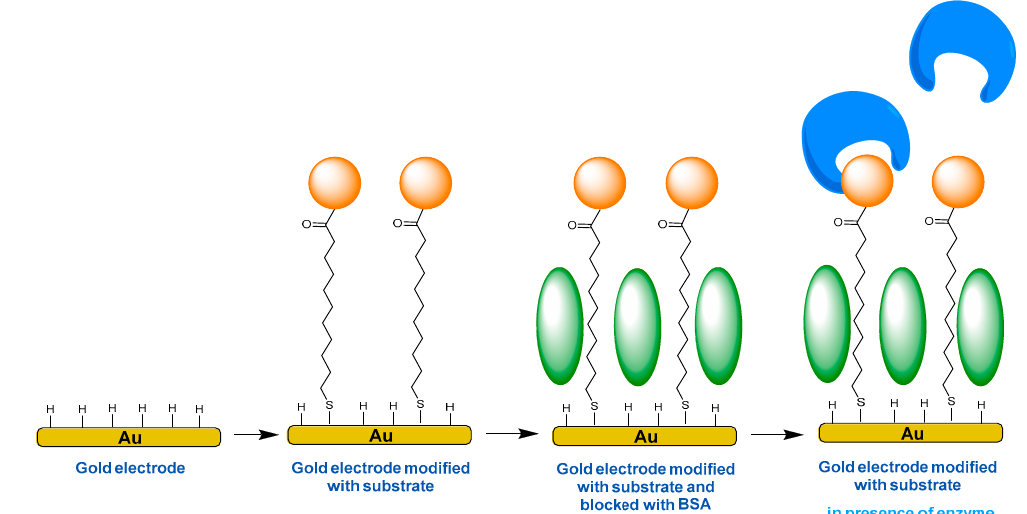
Figure 2. Schematic illustration of the electrochemical sensing platform for substrate-enzyme interactions.